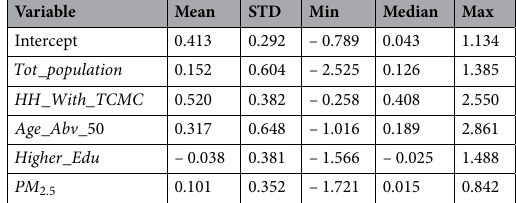
Table 5. Summary of the local model (GWR) for various socioeconomic, demographic, and environmental pollution related